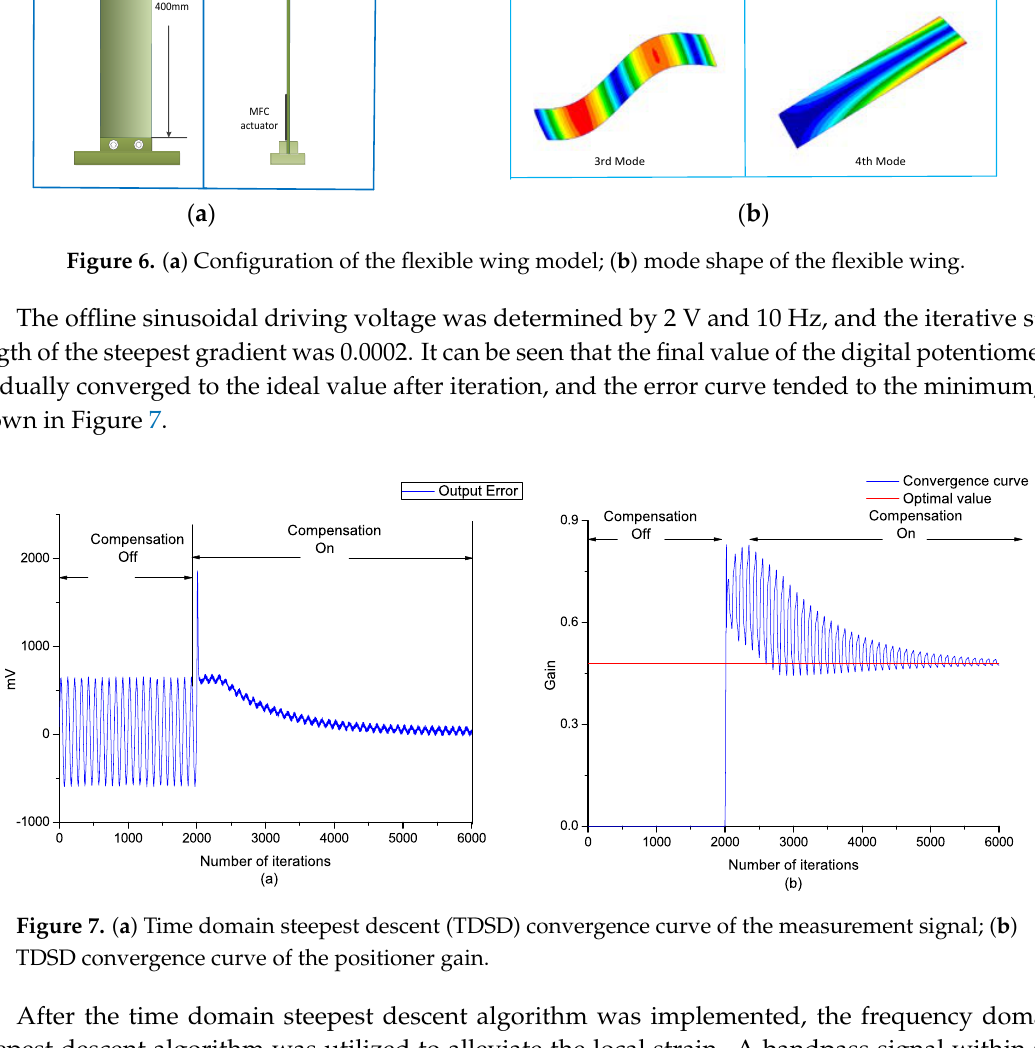
Figure 6. ( a ) Configuration of the flexible wing model; ( b ) mode shape of the flexible wing. Table 1. Comparison of numerical and experimental natural frequencies.